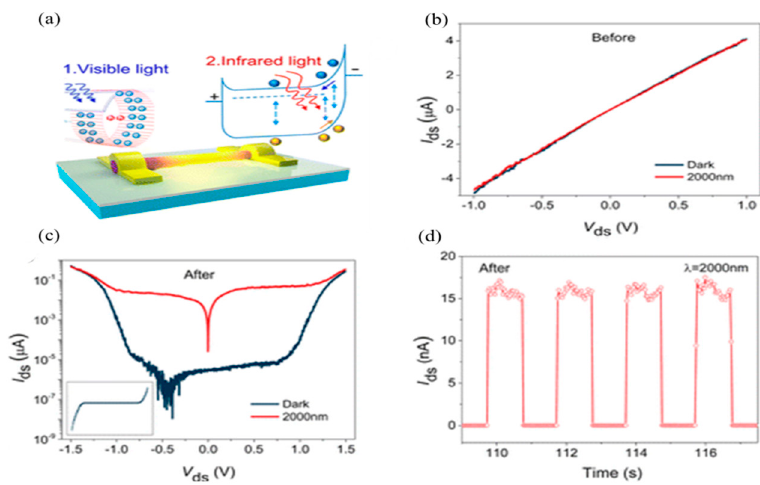
Figure 7. The reverse photo-response triggered IR detection in an InAs nanowire-based photodetector. ( a ) The single InAs nanowire with photo-gating mechanism under shorter wavelength illumination; ( b ) the photo-response before and ( c ) after shedding of light; ( d ) the photo-response measurement after optical activation indicating fast response speed about 100 µs in the device, (reproduced with the permission of Reference [38]. Copyright 2016, American Chemical Society).